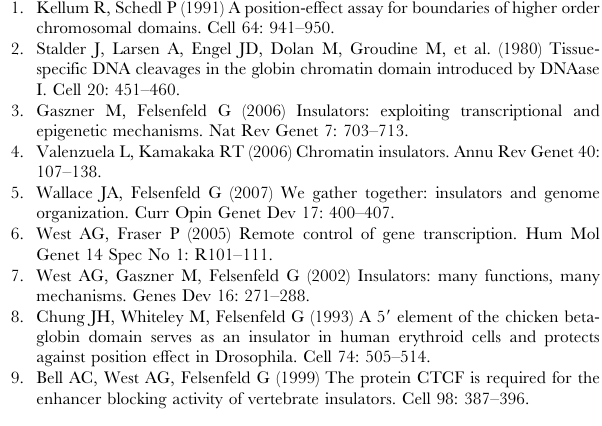
Figure S8 Transcription factor interactions with APRT CpG island elements. VEZF1 and SP1 interact with the wild type APRT